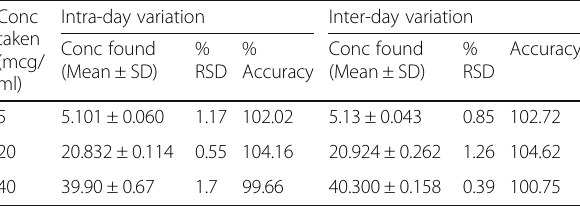
Table 4 Precision study of the HPLC analysis of